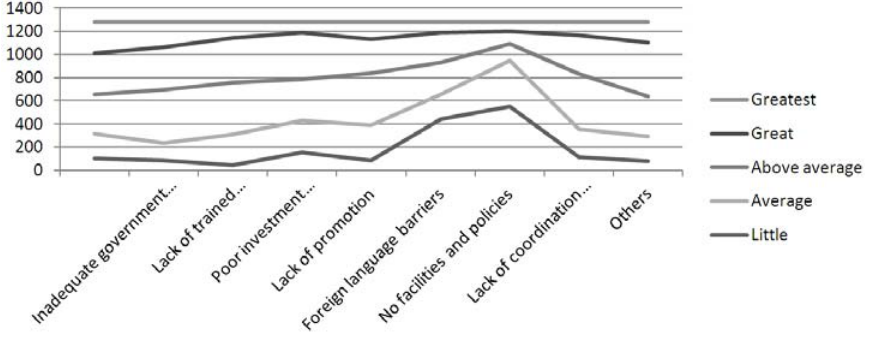
Fig. 6. Challenges for Indian medical tourism